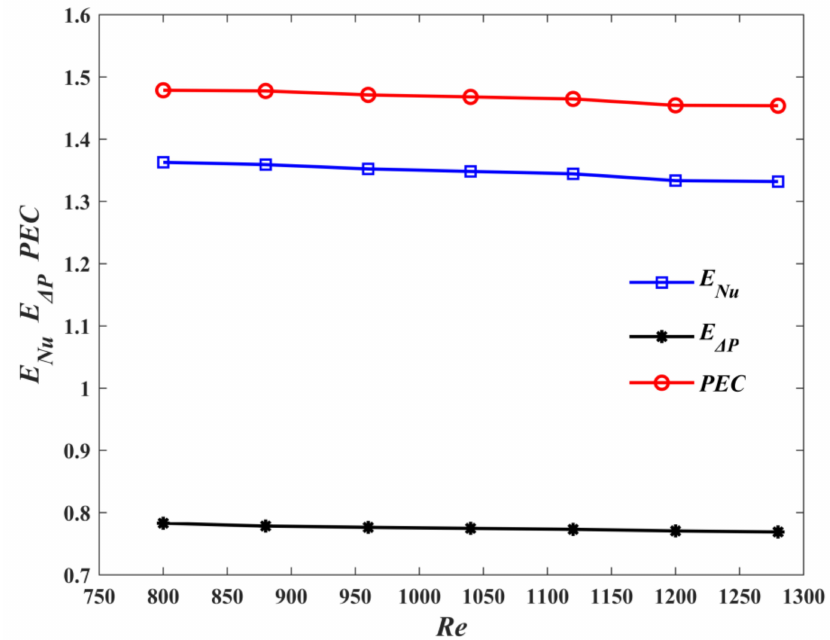
Figure 14. Effect of Re on E Nu , E ∆ P and PEC for M1.